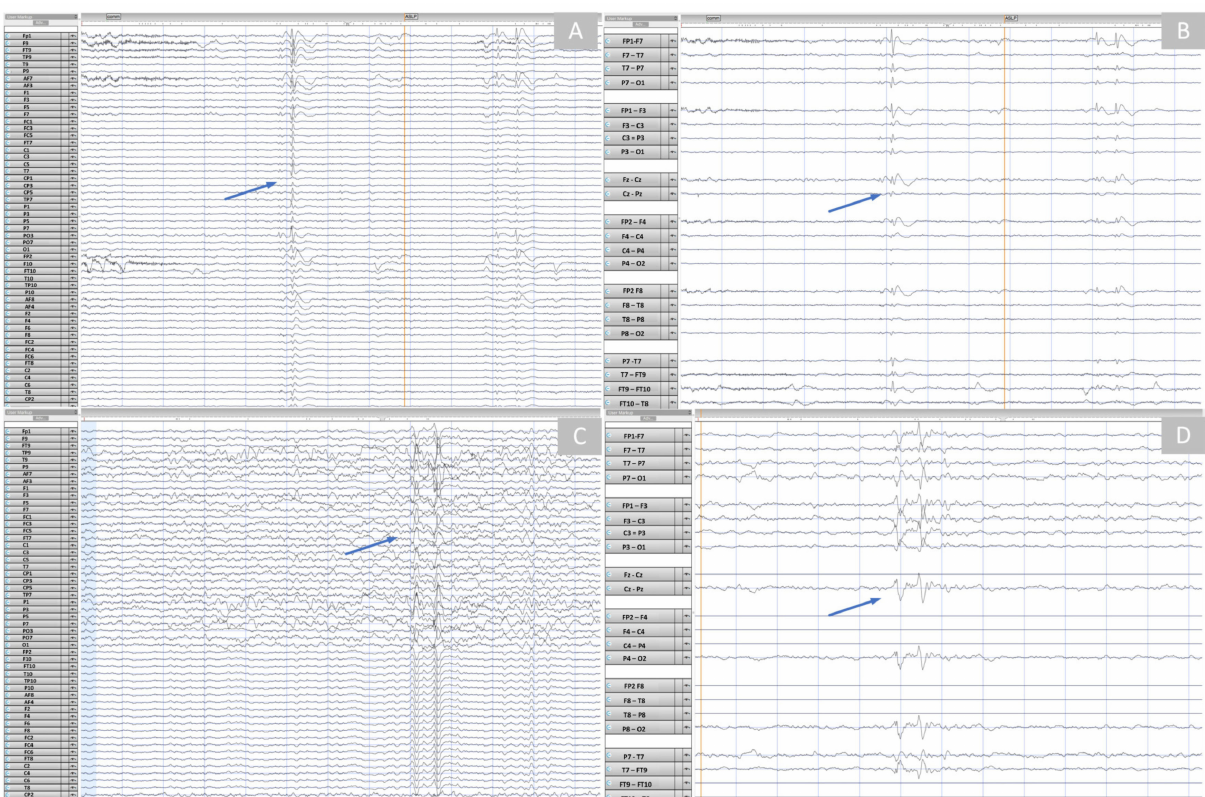
Figure 12. EEG Recording (outside the MRI) using the NeoNet vs. a commercial Net while the pediatric patient is asleep. ( A ) EEG screenshot from EGI (commercial) HD-EEG using 10–10 channel labels, system reference. Left frontotemporal spikes were visible. ( B ) EEG screenshot from EGI HD-EEG with spatially downsampled EEG to the 10–20 electrode positions, anterior–posterior bipolar reference. Note the complex field of the spike. ( C ) EEG screenshot from NeoNet EEG using 10–10 channel labs, system reference. The same left frontotemporal spike population was evident. ( D ) EEG screenshot from NeoNet EEG with spatially downsampled EEG to the standard 10–20 electrode positions, anterior–posterior bipolar reference. The same spike was shown (arrows). In the bipolar montage, the right-sided channels that carry the same signal (see ( C )) were now